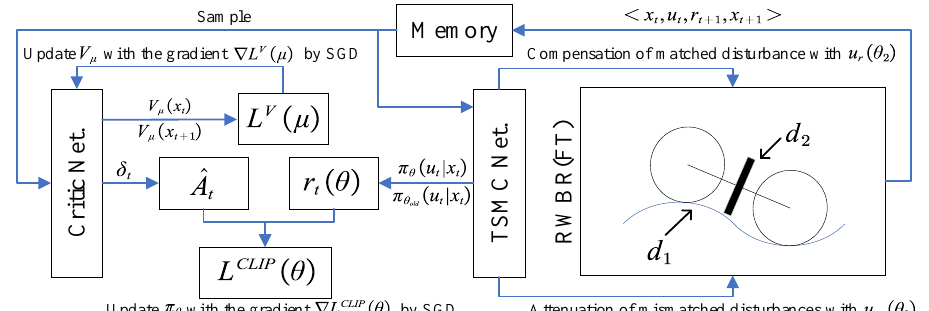
Figure 6. The framework of the